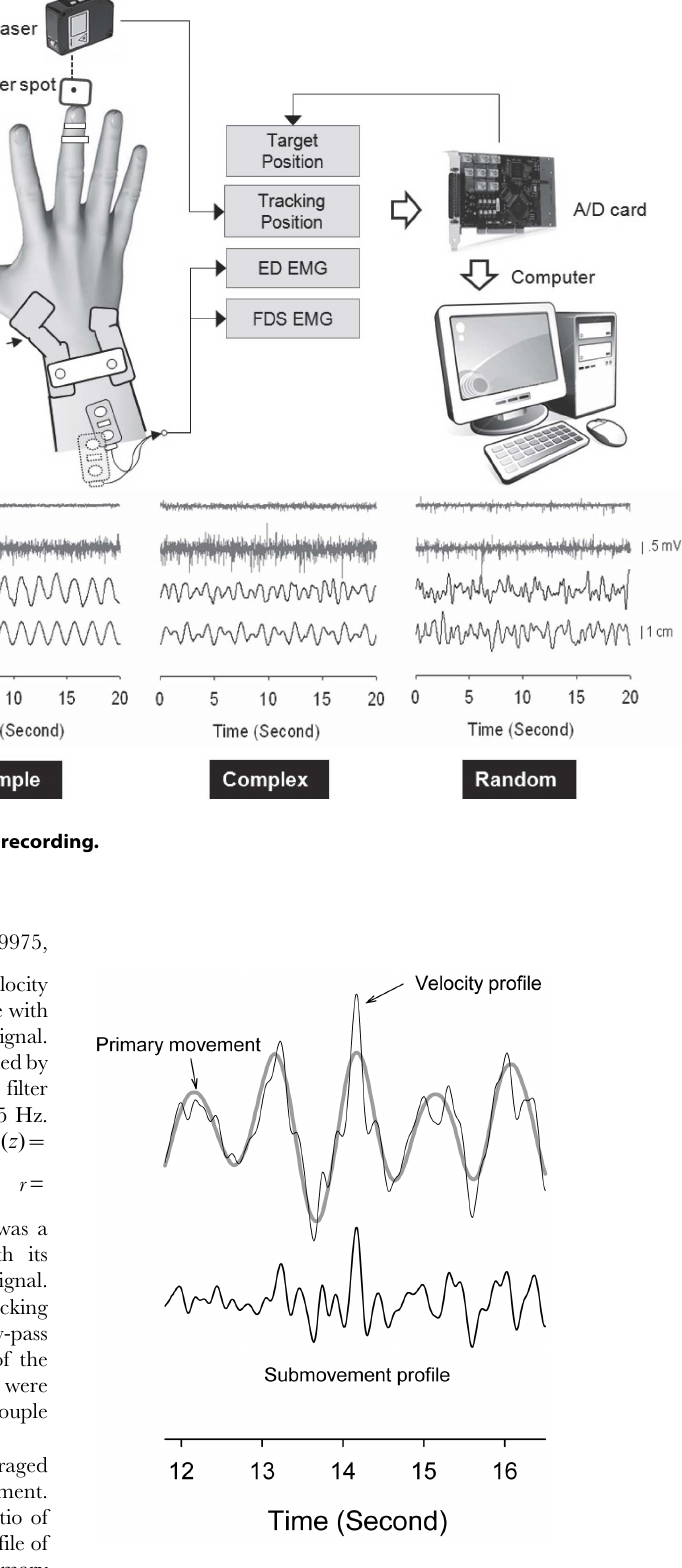
Figure 2. Schematic illustration of acquisition of primary movement and submovement profile from velocity profile during tracking.